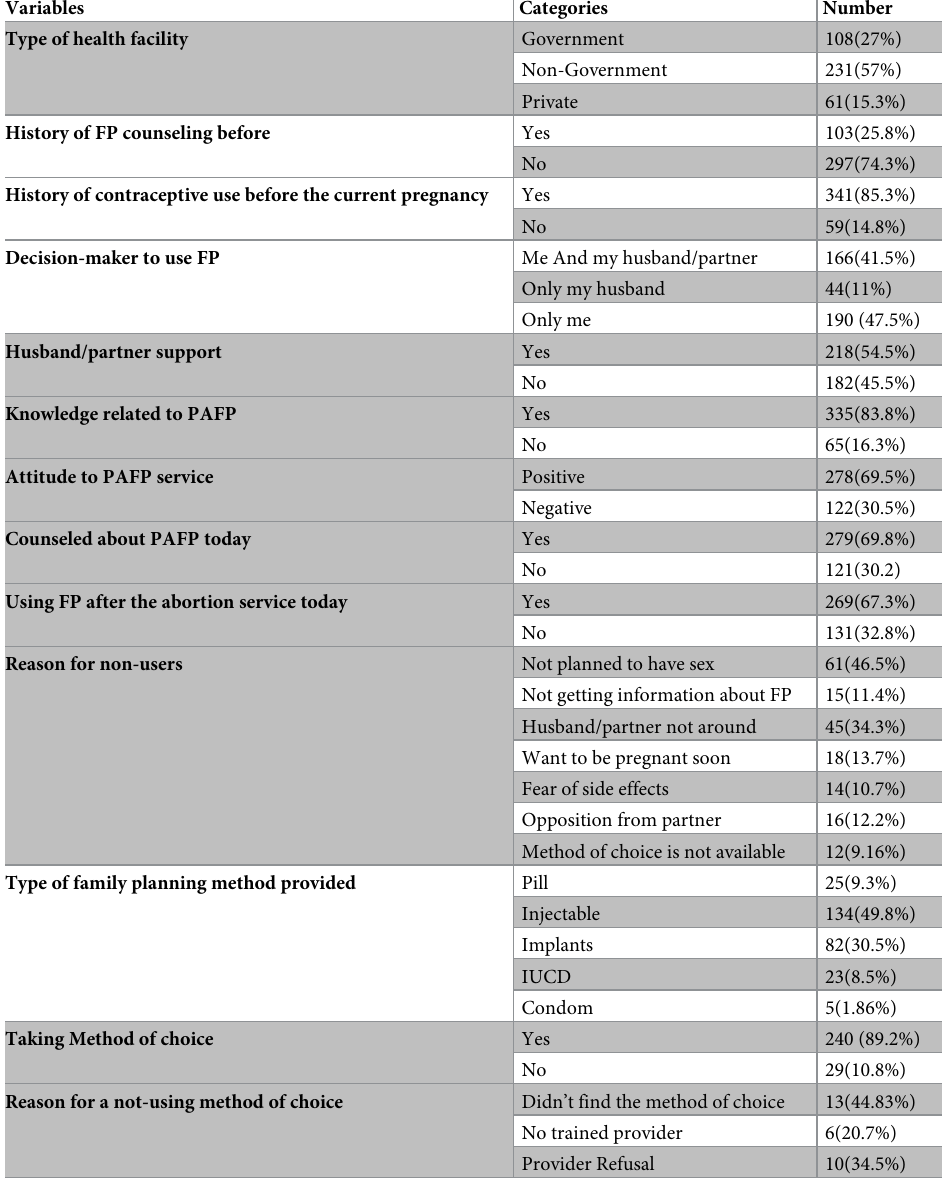
Table 3. Health service and contraceptive history of post-abortion clients, Wolaita Sodo,